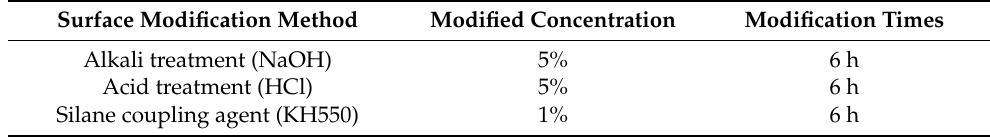
Table 3. PVA fiber surface modification.